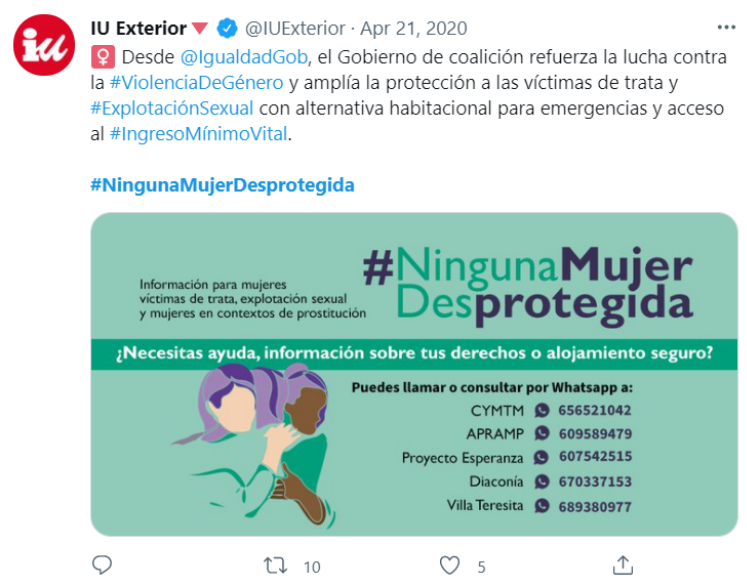
Figure 3. IU Twitter publication with an infographic from the Ministry of Equality with contact telephone numbers of civil society (April 2020). Source: https://twitter.com/hashtag/NingunaMujerDesprotegida?src=hashtag_click 20 (accessed on 1 April 2021).